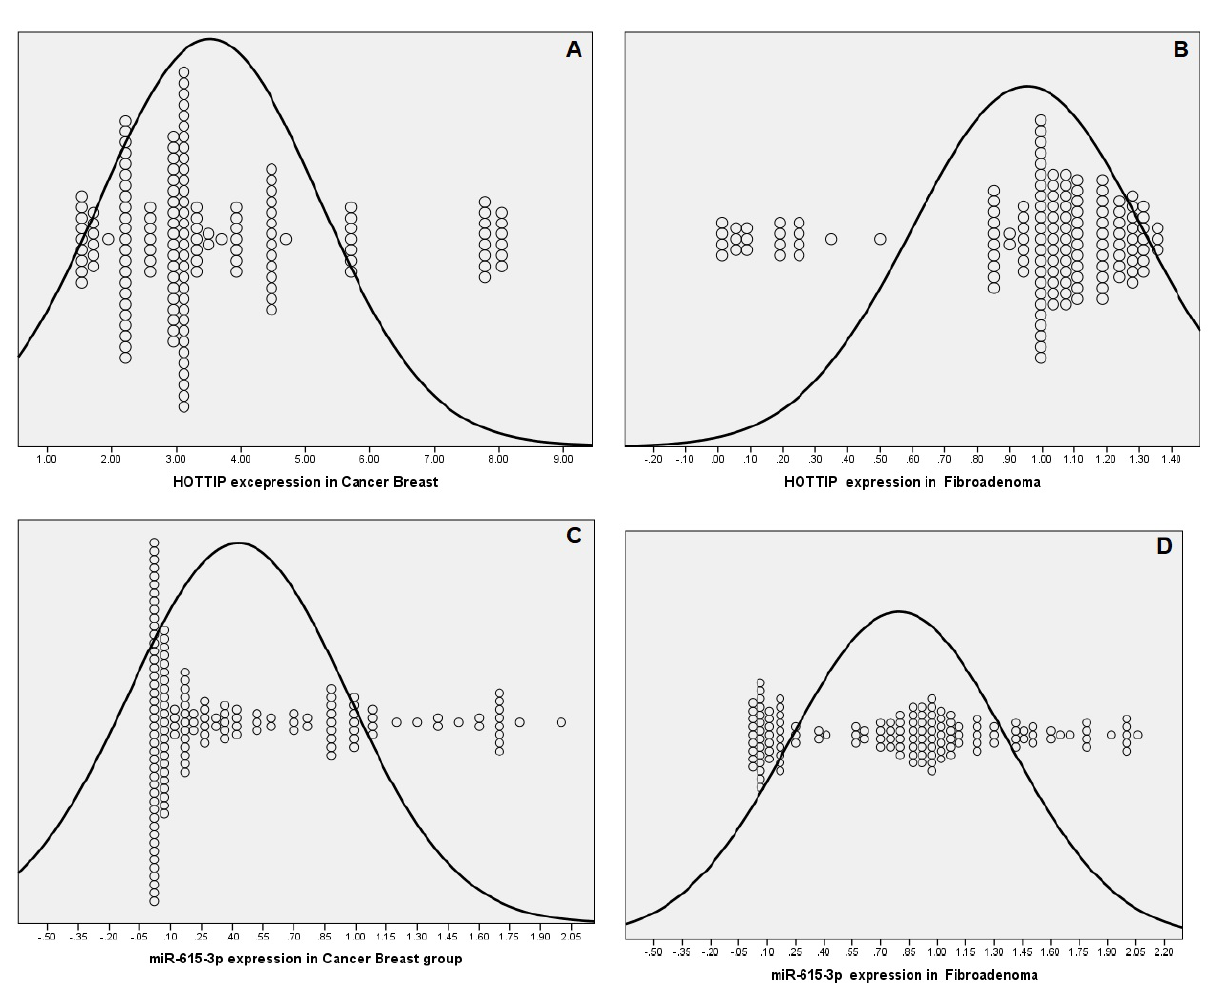
Figure 1. Dot plot representation of the relative expression serum levels of HOTTIP and miR-615-3p in all the study subjects: ( A ) Relative expression of the fold change of the serum HOTTIP in breast cancer patients. ( B ) Relative expression of the fold change of the serum HOTTIP in fibroadenoma patients. ( C ) Relative expression of the fold change of the serum miR-615-3p in breast cancer patients. ( D ) Relative expression of the fold change of the serum miR-615-3p in fibroadenoma